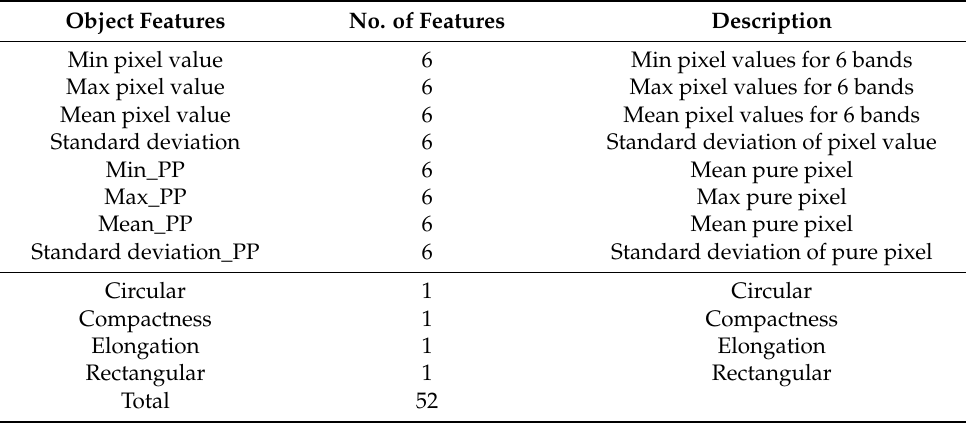
Table 2. Associated attributes of segmented images. Adapted from